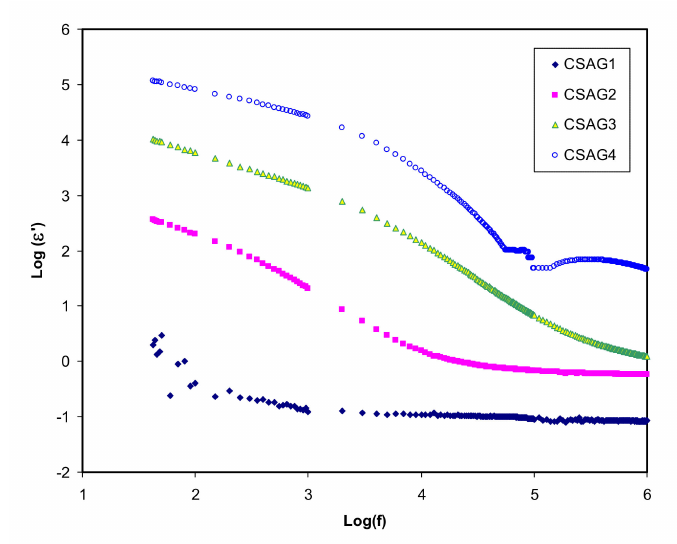
Figure 2. Dielectric constant ( ε (cid:48) ) against frequency of electrolyte samples (CSAG1–CSAG4) at ambient